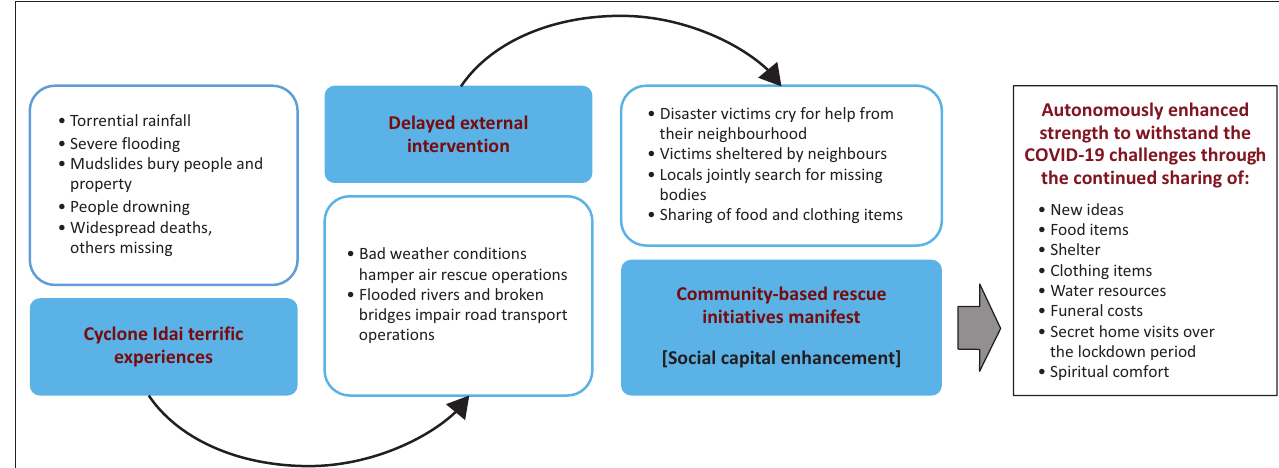
FIGURE 1: Conceptual analysis of community capital enhancement in Chimanimani during and after the Cyclone Idai